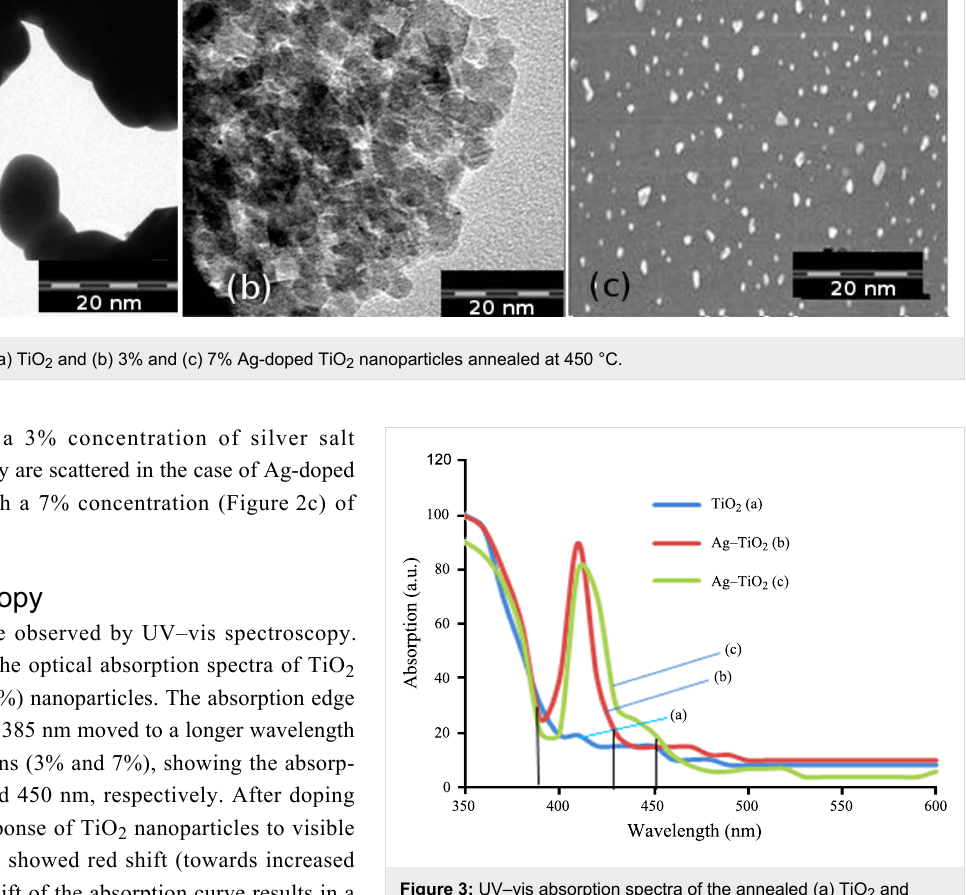
Ag–TiO 2 (7%), respectively, by extrapolation of the linear portion of the absorption coeffiecient α to zero for indirect- band-gap nanoparticles. The obtained band-gap energy for indi- rect allowed transitions is in good harmony with the previously reported values [18]. The optical band-gap energies decrease with the doping of silver ions, which allow the delay in recom- bination rate and enhance the photocatalytic